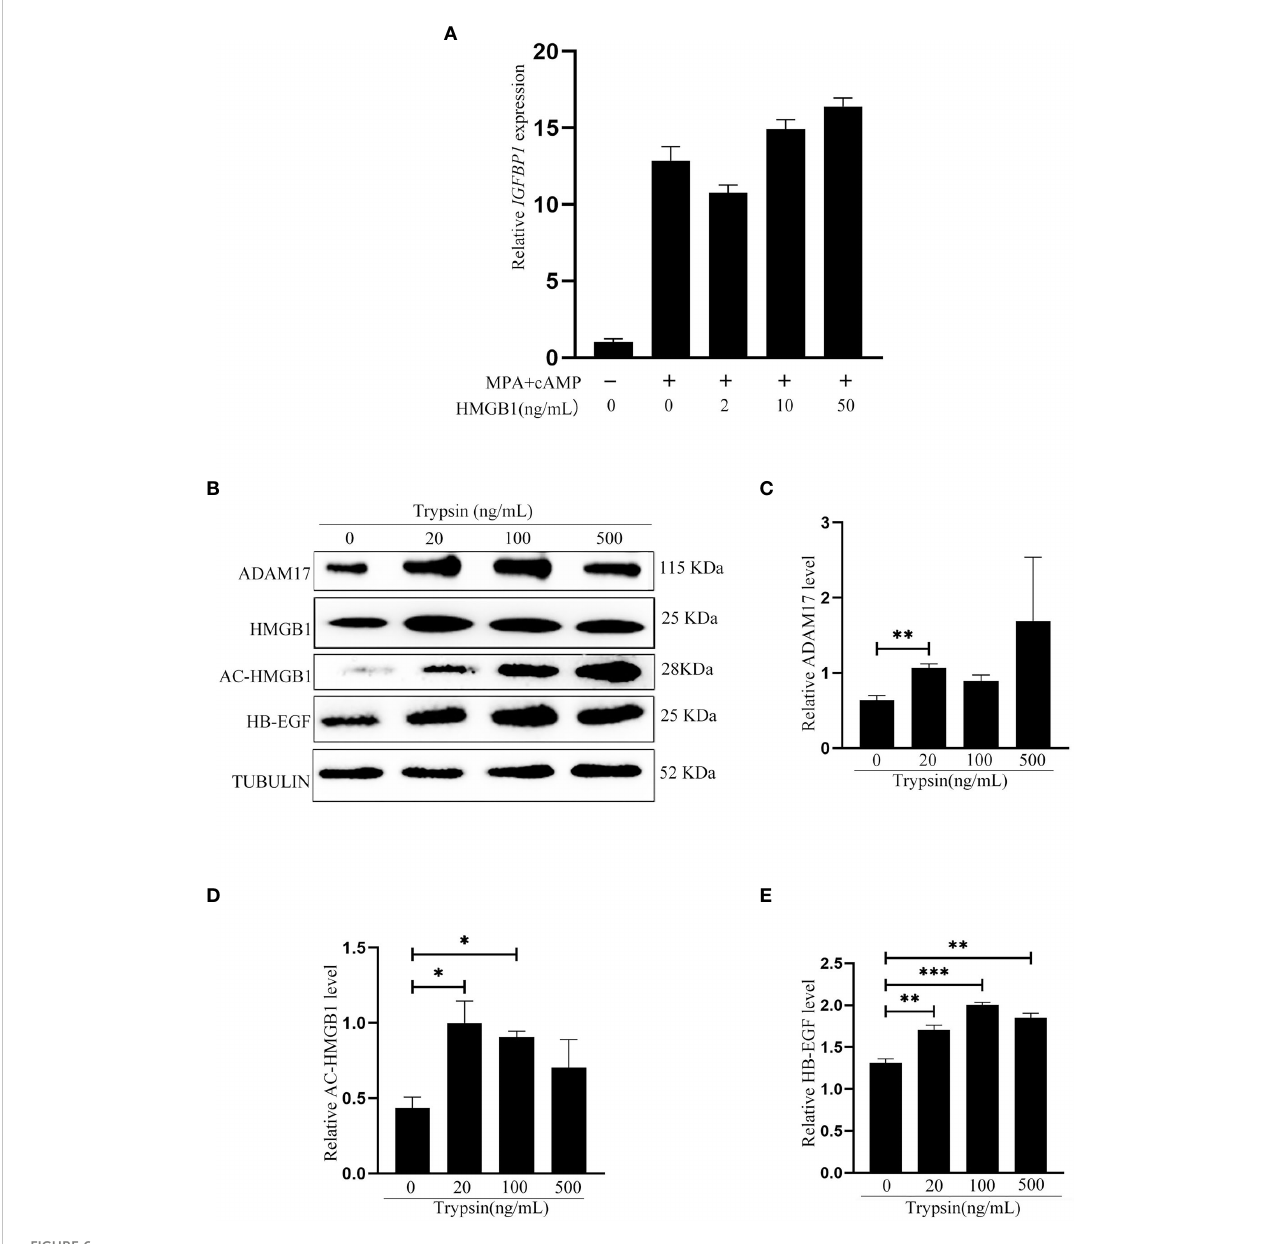
FIGURE 6 Effects of exogenous HMGB1on human decidualization and human uterine epithelial cells. (A) Effects of exogenous HMGB1 on IGFBP1 mRNA level under in vitro decidualization. (B) Western blot analysis on the protein levels of ADAM17, HMGB1, Ace-HMGB1 and HB-EGF after human Ishikawa epithelial cells were treated with trypsin. (C-E) The relative protein levels of ADAM17, acetylated HMGB1 and HB-EGF in Figure 6B, respectively. *p < 0.05; **p < 0.01, ***p <